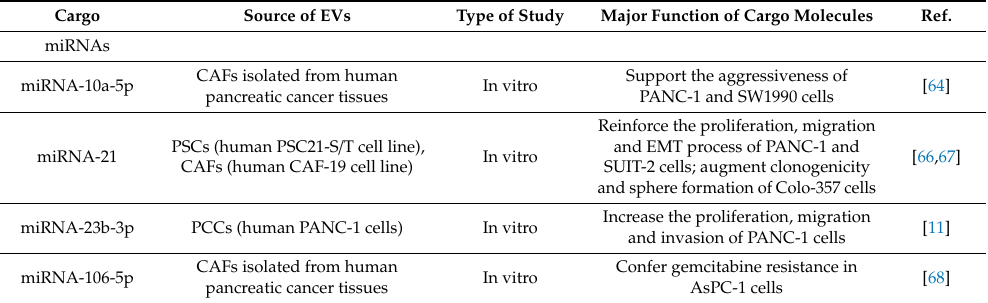
Table 1. Cargo molecules in EVs from various types of cells and e ff ects of cargo molecules on pancreatic cancer cells